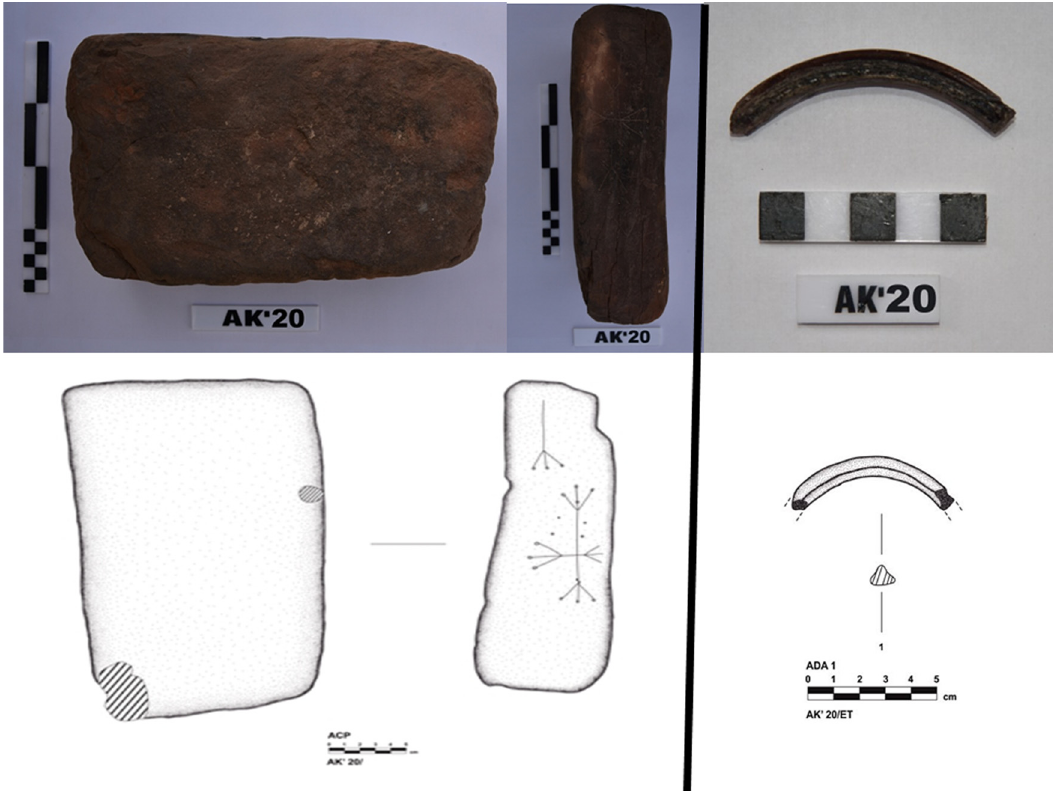
Figure 11: Photograph and drawing of Terracota plate ( WS6 ) and carinated glass bracelet ( WS7 ) ( Ambarçay Salvage Excavation Archive )